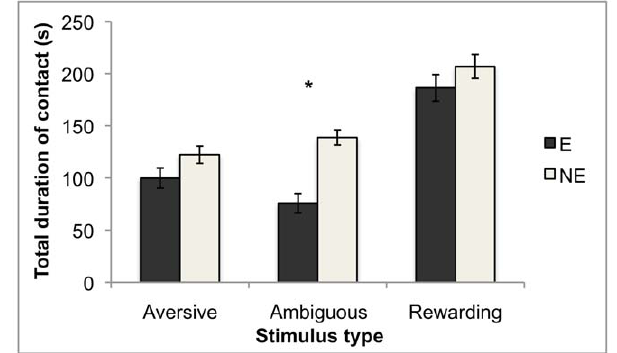
Figure 3. Duration in contact with the stimulus, split by housing treatment and stimulus type. Data are means 6 standard error. * indicates a significant difference at the group a =0.05 level (Tukey’s HSD). A version of this figure based on earlier statistical models was included in Meagher [81].